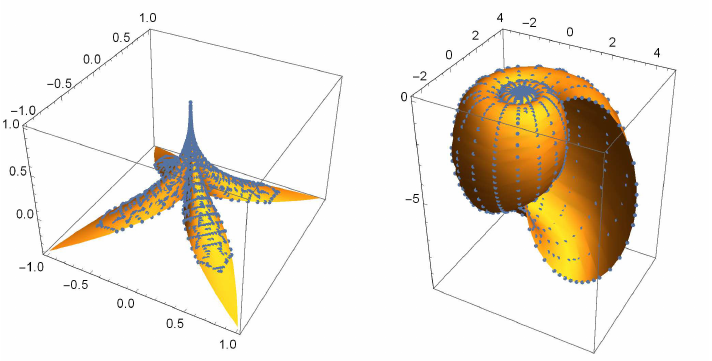
Fig. 3 The surfaces with the parameterizations φ 1 ( t , s ) (on the left) and φ 2 ( t , s ) (on the right), and the points sampled on them.